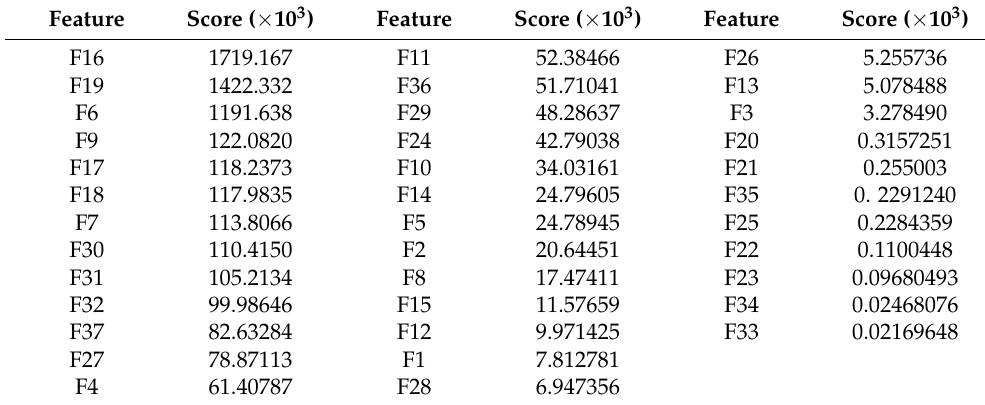
Table 4. List of selected features after preprocessing